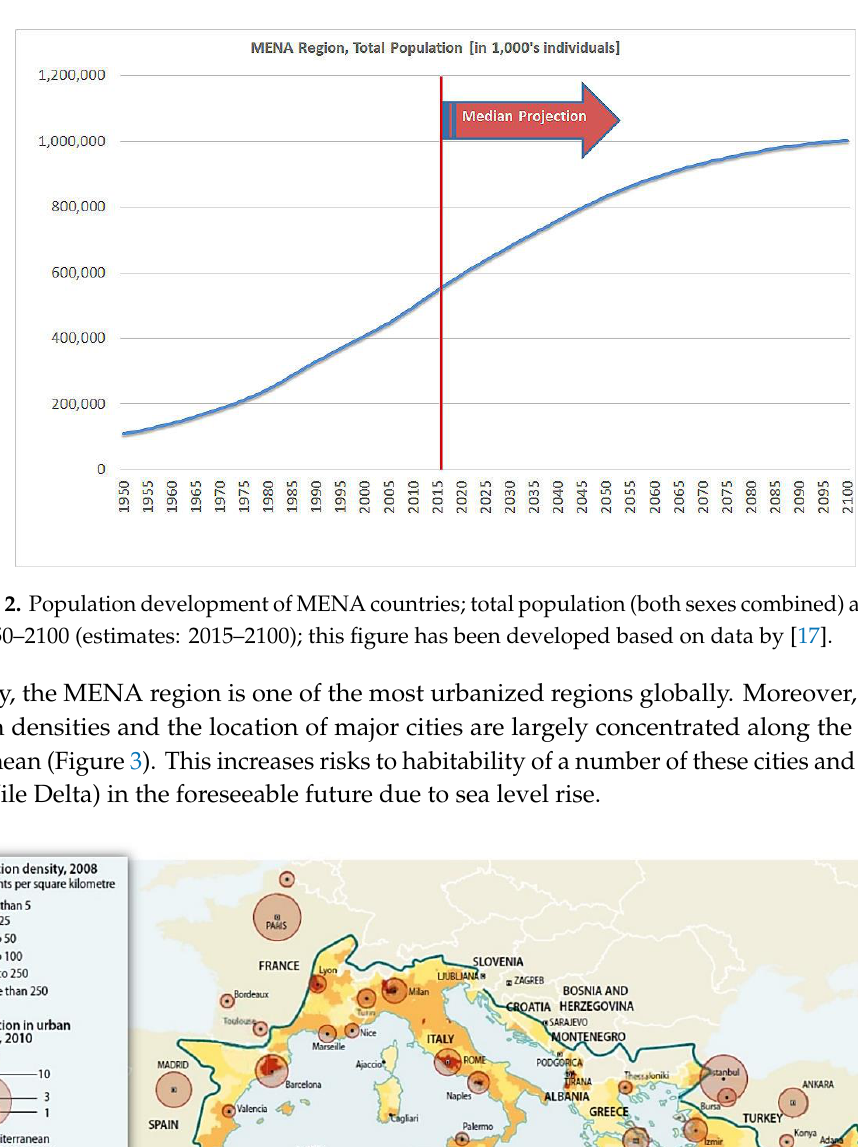
Figure 3. Population densities of Mediterranean countries, including Mediterranean MENA countries; source [19] .